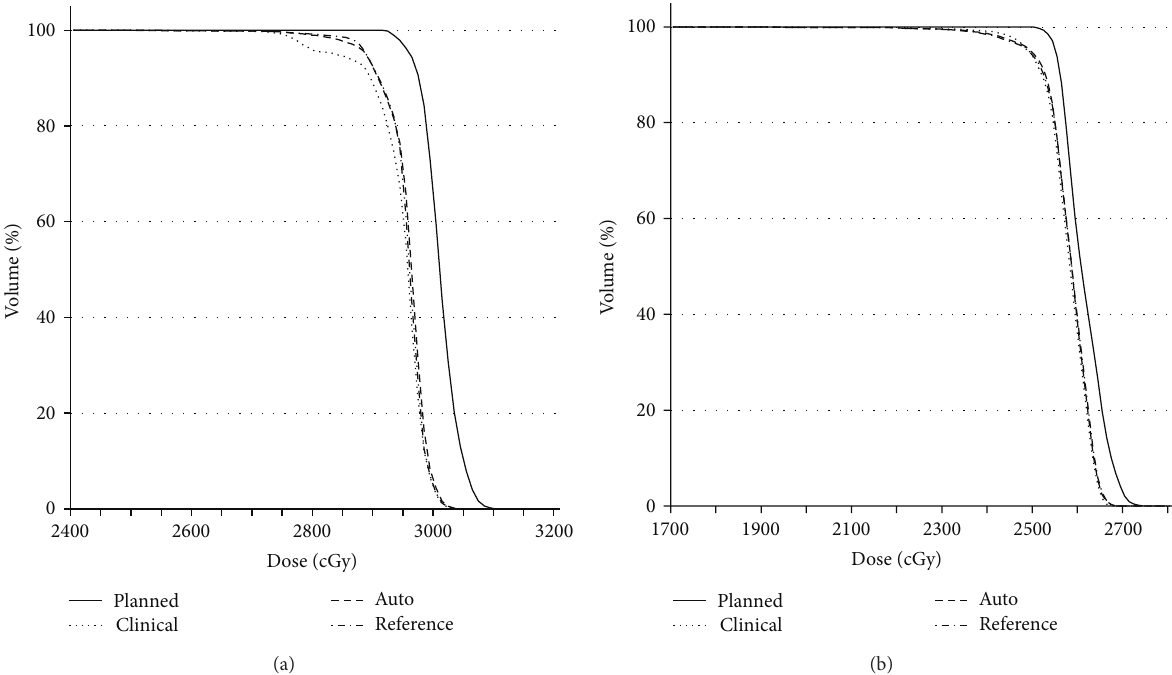
Figure 11: Prostate accumulated-dose DVHs for two patients. The planned doses have been scaled to the number of fractions accumulated for each